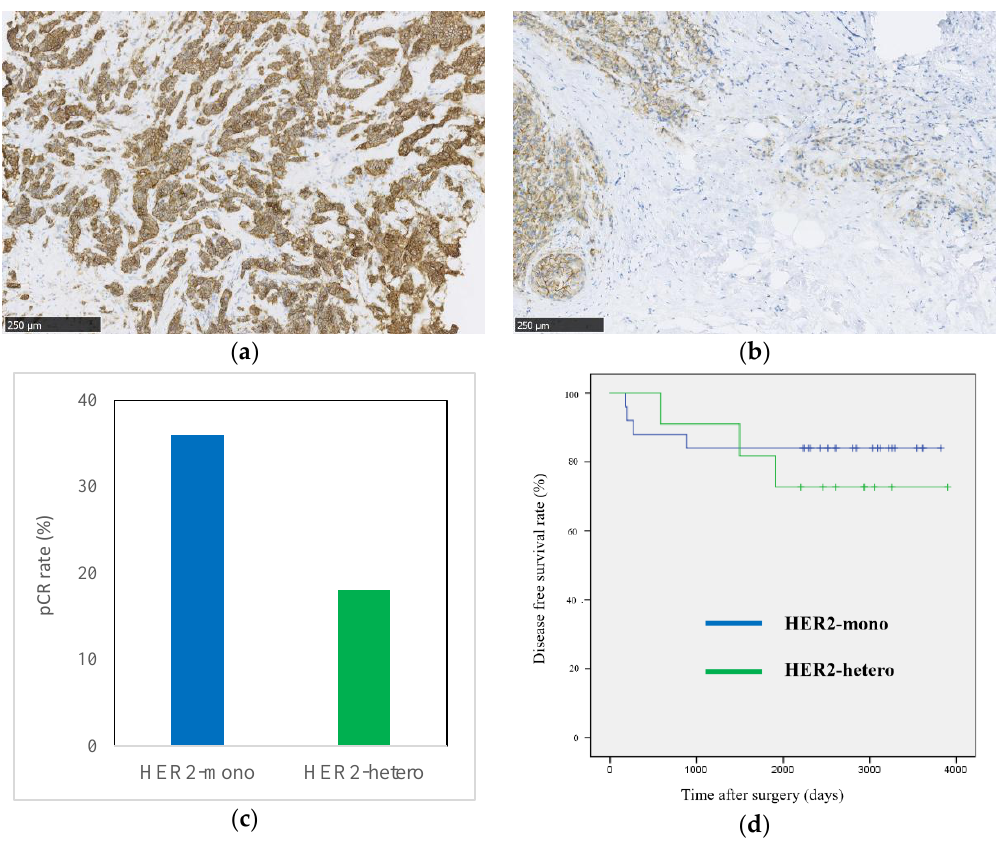
Figure 3. Heterogeneous HER2 expression is correlated with a high risk of relapse and resistance to chemotherapy plus trastuzumab in patients with HER2-positive breast cancer. ( a ) Representative IHC staining of HER2-mono tumors. Scale bar, 250 μm; ( b ) representative IHC staining of HER2-hetero tumors. Scale bar, 250 μm; ( c ) PCR rate of HER2-positive breast cancer patients treated with chemotherapy plus trastuzumab ( p = 0.29); ( d ) Disease free survival (DFS) curves of patients with HER2-positive breast cancer after neoadjuvant chemotherapy plus surgery. The median DFS has not been reached ( p = 0.97).